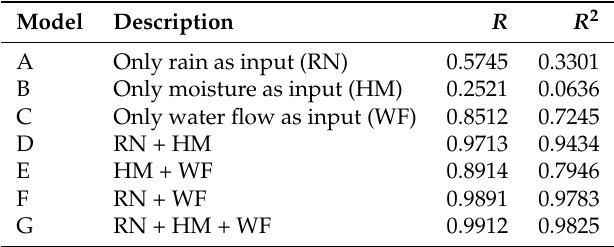
Table 5. MLP correlation and coefficient of determination [13].